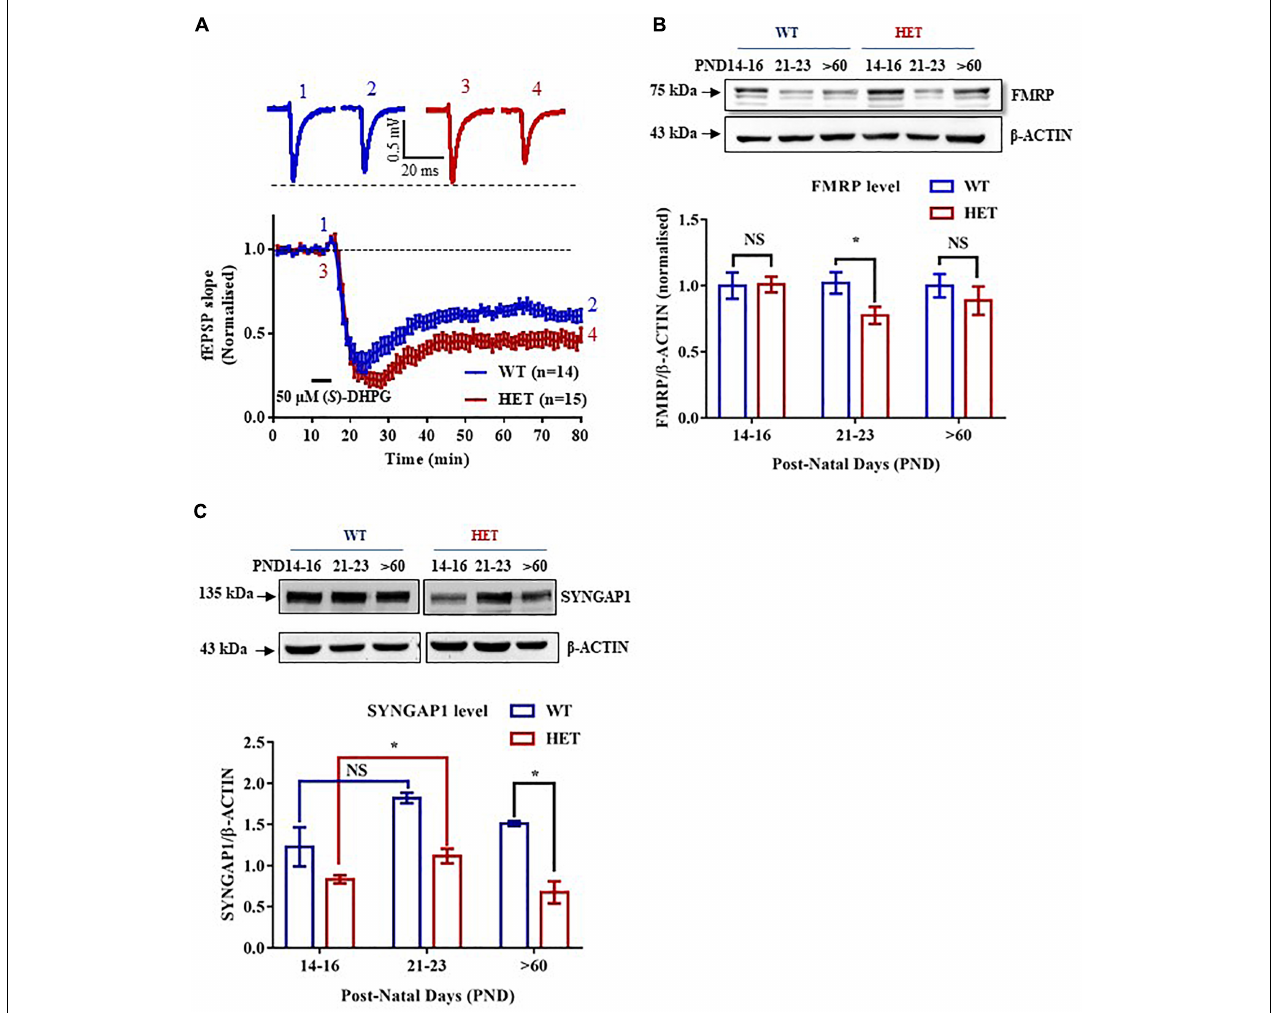
FIGURE 1 | Altered expression of FMRP in the Hippocampus of Syngap1 − / + during development. (A) Application of 50 µ m ( S )-DHPG induced enhanced Group I mGluR mediated LTD in the Schaffer-Collateral pathway of adult (PND90) Syngap1 − / + (HET) compared to WT (WT) littermates. Sample traces obtained before and after the induction of LTD as indicated by time points ( top ). WT = 61 ± 3% LTD, n = 14; HET = 47 ± 4% LTD, n = 15; Unpaired Student’s t -test; ∗ p < 0.05. (B) Representative immunoblot for FMRP level in the hippocampus during development ( top ). Pooled data of FMRP level normalized to β -ACTIN in the hippocampus during development, normalized to the level of WT ( below ). PND14-16 (WT: N = 10; HET: N = 8), PND21-23 (WT: N = 10; HET: N = 8), PND > 60 (WT: N = 8; HET: N = 10). ∗ p < 0.05; Unpaired Student’s t -test. (C) Representative Immunoblots for SYNGAP1 during development ( top ). Histogram depicts SYNGAP1 level normalized to β -ACTIN in WT and HET at PND14-16, PND21-23, and PND > 60 (WT: N = 4; HET: N = 3). Bar graph shows increased SYNGAP1 level in HET during PND21-23 (WT: N = 4; HET: N = 5) when compared to PND14-16 (WT: N = 5; HET: N = 5) while no significant change was observed in WT. All WT and HET samples for individual age groups were run on the same gel. Two-way ANOVA; Unpaired Student’s t -test; ∗ p < 0.05, NS, not significant.